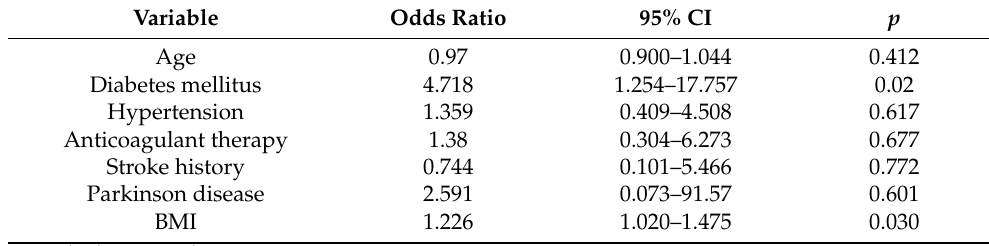
Table 5. Multivariable logistic regression analysis of factors predicting low preoperative testos- terone